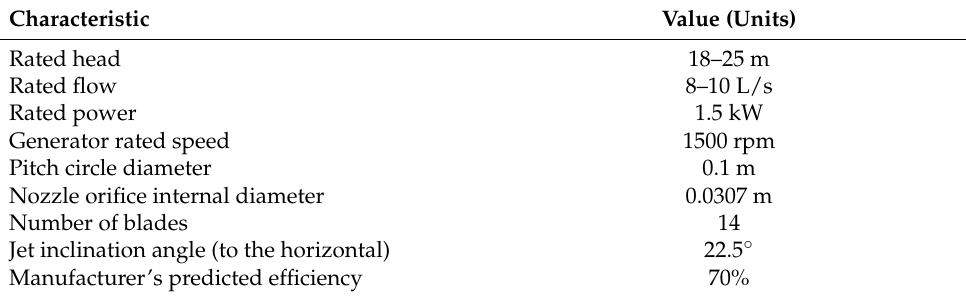
Table 1. Imported Turgo turbine specification